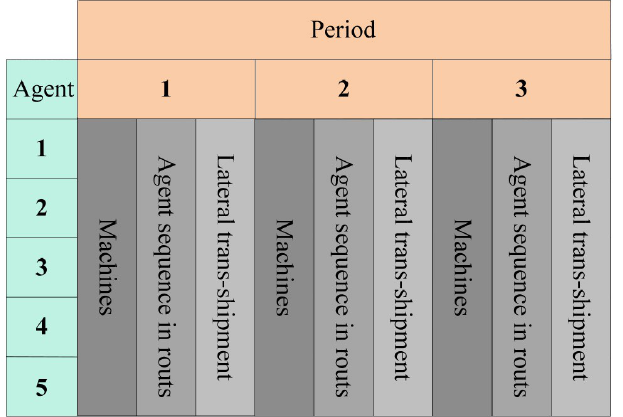
Figure 4. Proposed chromosome as a single line